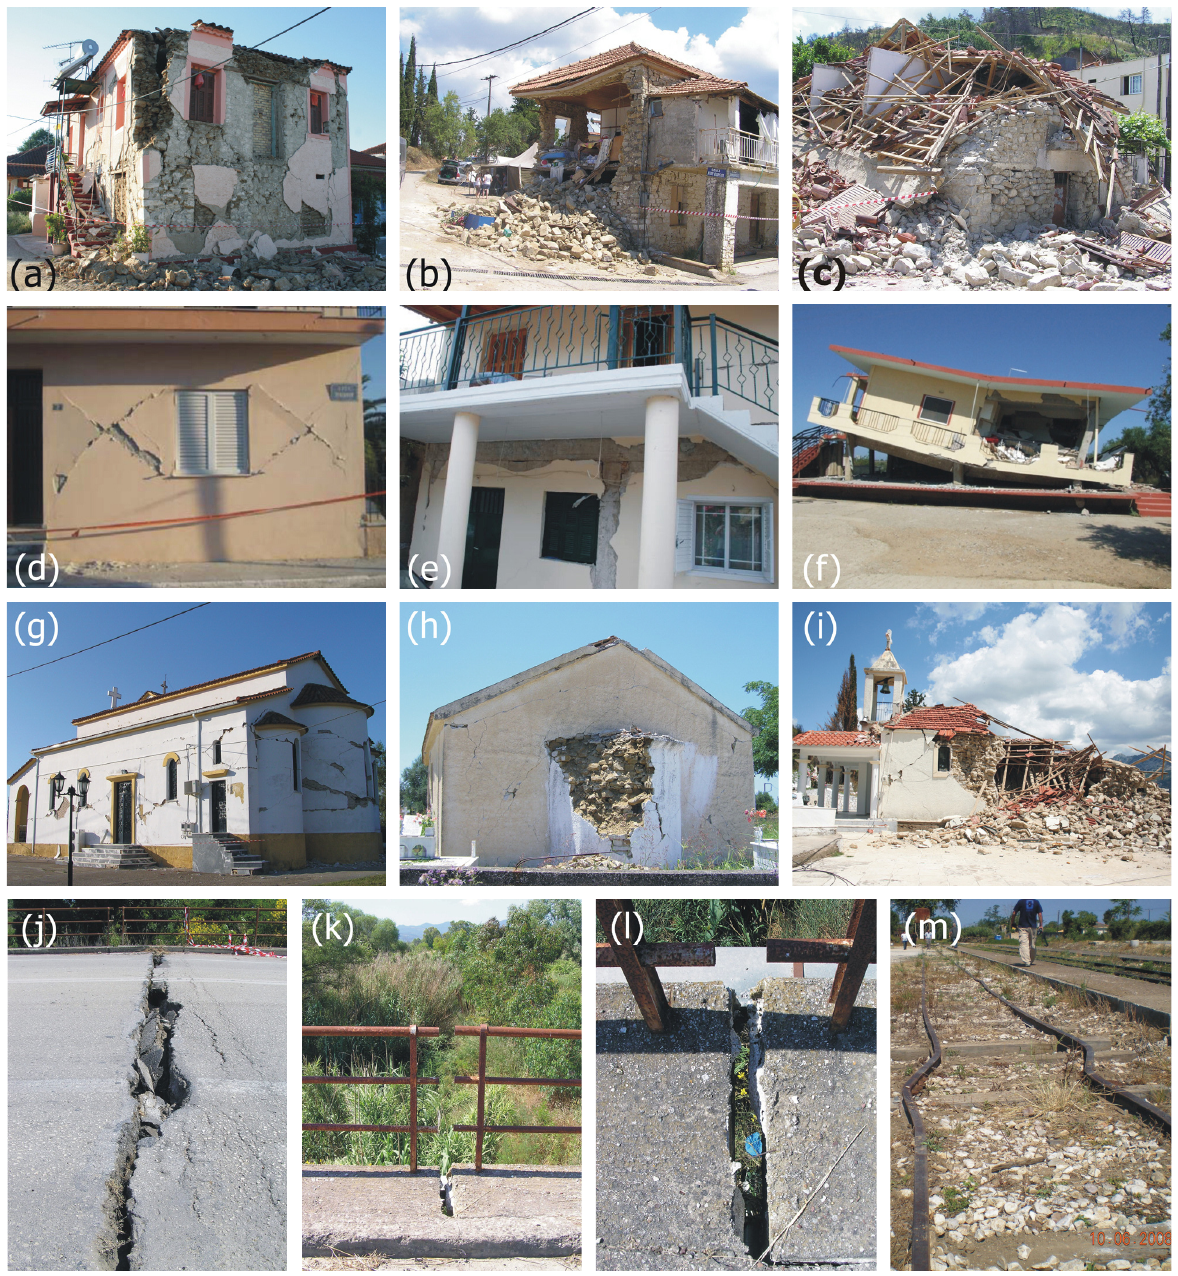
Figure 5. Structural damage induced by the 2008 Andravida earthquake: (a) damage of grade 3 to masonry building in the Nissi village in- cluding large and extensive cracks in most walls and fall of very large pieces of plaster, (b) damage of grade 4 to masonry building in the Valmi village including partial collapse of walls, (c) damage of grade 5 to masonry building in the Valmi village including total or near total collapse, (d) damage of grade 2 to R/C building in the Stafidokampos village including diagonal cracking in brick partition wall, (e) damage of grade 3 to R/C building in the Valmi village including detachments of the walls from the surrounding R/C frame and (f) damage of grade 5 to R/C building in the Didacheika village including collapse of ground floor due to damage to R/C elements, (g, h, i) damage to monumental build- ings including (g) cracks observed at the exterior walls as well at the junctions of the exterior walls, at several interior masonry arches and around openings or at the top of the exterior walls on which wood roofs rest (Nissi village), (h) partial collapse of the exterior walls (Psari area), (i) total collapse of the church (Valmi village). (j, k, l) Damage to bridges included cracks in the road asphalt surface, transverse to the longitudinal axis of the bridge (Kato Achaia area). (m) Railway line in the Kato Achaia train station deformed by the